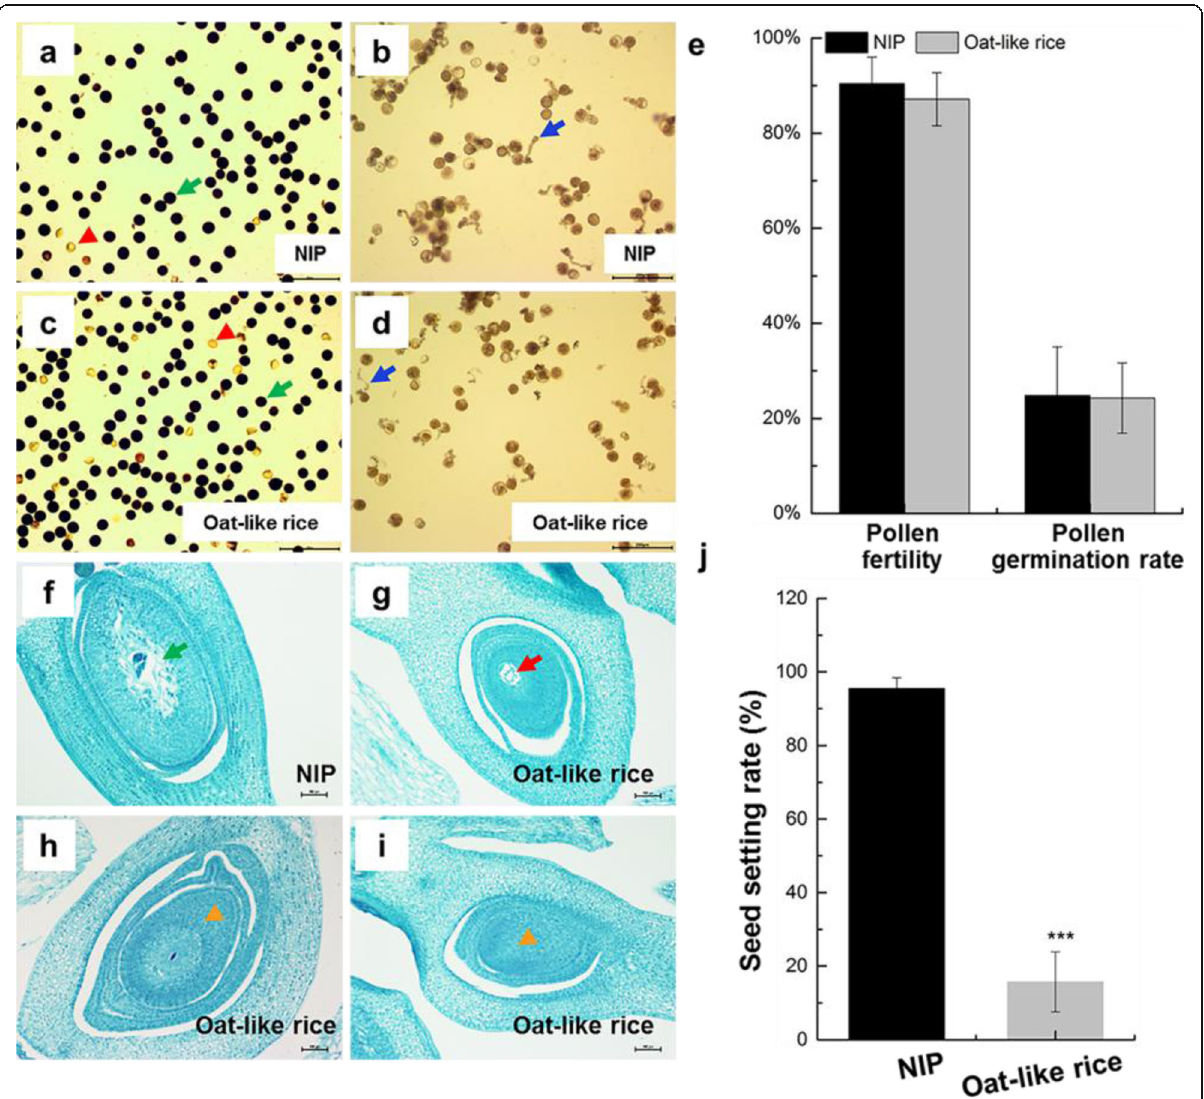
Fig. 5 Fertility analysis of Oat-like rice. a-d Characterization of male fertility in NIP ( a and b ) and Oat-like rice ( c and d ). a and c I 2 -KI staining of pollen grains from NIP ( a ) and Oat-like rice ( c ). Red arrowheads indicate aborted pollen grains, green arrows indicate normal pollen grains ( a and c ). b and d Pollen in vitro germination assay of NIP ( b ) and Oat-like rice ( d ). Blue arrows indicate germinated pollen grains with pollen tubes ( b and d ). e Comparison of pollen fertility and pollen germination rate between NIP and Oat-like rice. f-i Comparison of mature embryo sacs between NIP ( f ) and Oat-like rice ( g - i ) by paraffin sections. f-i Longitudinal sections of mature carpels from NIP ( f ) and Oat-like rice ( g - i ). The green arrow in f indicates normal and mature embryo sac; the red arrow in g indicates shrinked embryo sac; orange arrowheads in h and i indicate that embryo sacs did not develop and were replaced with an abnormally proliferated nucellus. j Comparison of seed setting rate between NIP and Oat-like rice. Data presented are mean values ± SDs [ n =12 replicates in e ; n =24 replicates in j .]. Student ’ s t -test: *** p <0.001. Bars: ( a - d ) 200 μ m; ( f - i ) 100 μ